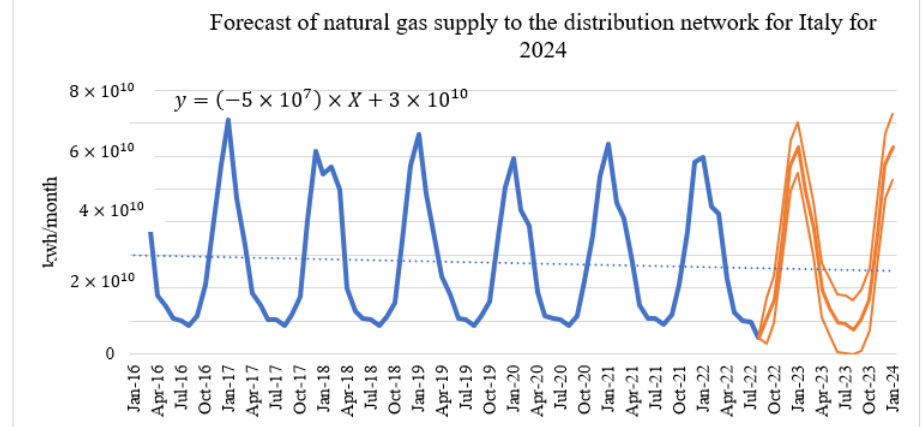
Figure 3. Forecast of natural gas supply to distribution network for Italy for 2024. These data can be found here: https://www.ec.europa.eu/ (accessed on 20 March 2022).